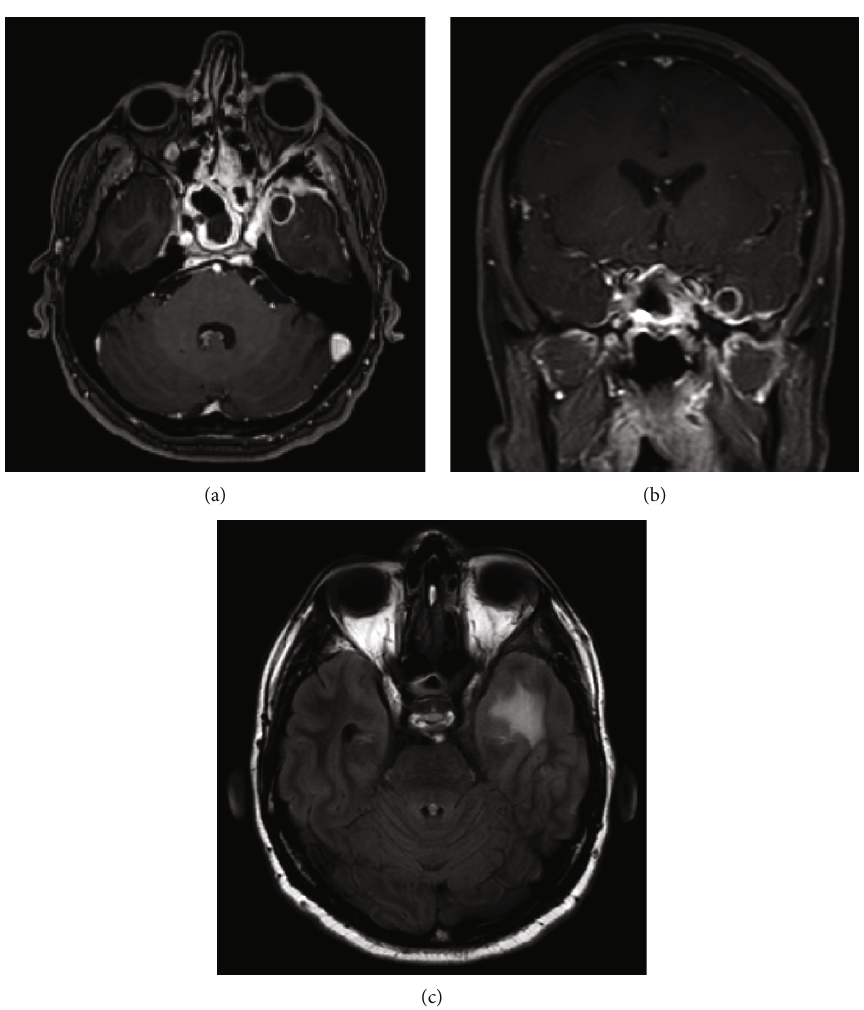
Figure 1: (a) Axial T1-weighted brain MRI with contrast. (b) Coronal T1-weighted brain MRI with contrast. (c) Axial T2-weight fl uid- attenuated inversion recovery brain MRI. (a, b) The images demonstrate a left medial temporal lobe well-de fi ned, ring-enhancing lesion measuring 1 : 2 × 1 : 3 × 1 : 2 cm in anteroposterior, transverse, and craniocaudal dimensions. There is bilateral pachymeningeal enhancement, mostly involving the middle cranial fossa, worse on the left side. Asymmetric enhancement of the left cavernous sinus is noted as well as left eye proptosis. There is enhancement of the left lateral recuts muscle. There are signi fi cant mucosal thickening, enhancement, and air- fl uid level in the sphenoid sinus and ethmoid sinus. (c) A left temporal vasogenic edema is noted. (a – c) These fi ndings are suggestive of invasive sinusitis complicated by skull base osteomyelitis with intraorbital and intracranial